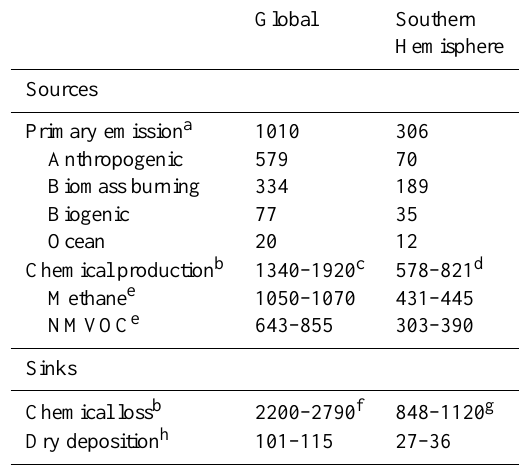
Table 2. Global and southern hemispheric CO budgets (Tgyr − 1 ) for 2004 in the SHMIP simulations.